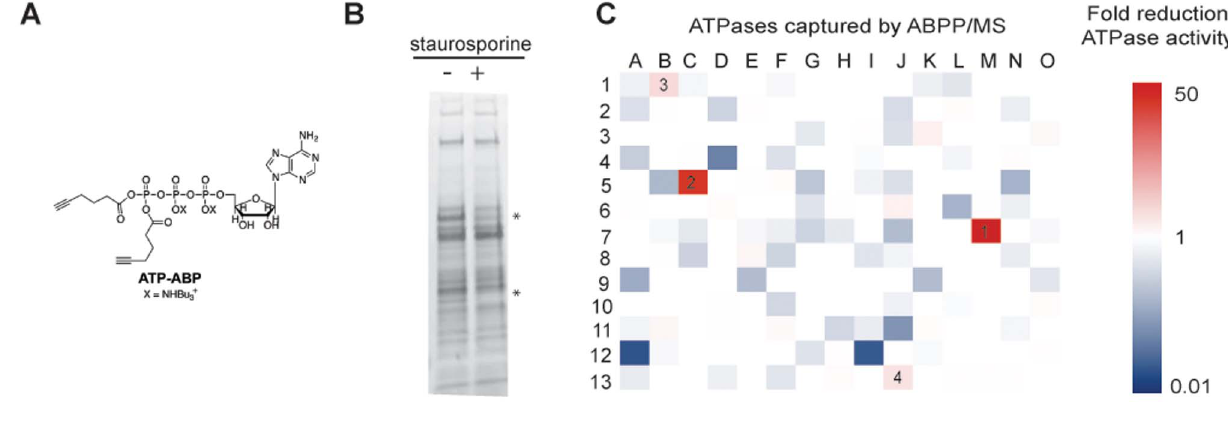
Figure 2. Competitive ABPP identifies PknB, D, and F as staurosporine targets. (A) Structure of the ATP activity-based probe. (B) Grey scale image of Mtb lysate fluorescently labeled following ABPP. Detergent-solubilized Mtb proteome was treated with staurosporine at 25-fold molar excess over ATP-ABP before labeling with ATP-ABP at subsaturating concentrations and analysis by SDS-PAGE. Probe shows labeling of ATPases and competition of staurosporine with binding to some ATPases (asterisks). (C) Heatmap representation of MS analysis of competitive ABPP to identify staurosporine targets. ATPase abundance was measured by quantitative, AMT tag approach mass spectrometry. Each square represents one Mtb H37Rv protein, ordered by Rv number from left to right. Color-coding represents the average fold-reduction of protein quantity in staurosporine- treated versus untreated samples from six technical replicates. Reduced ATP-ABPP probe binding in the presence of staurosporine identifies PknF (1), PknE (2), and PknB (3) as the primary targets of staurosporine.